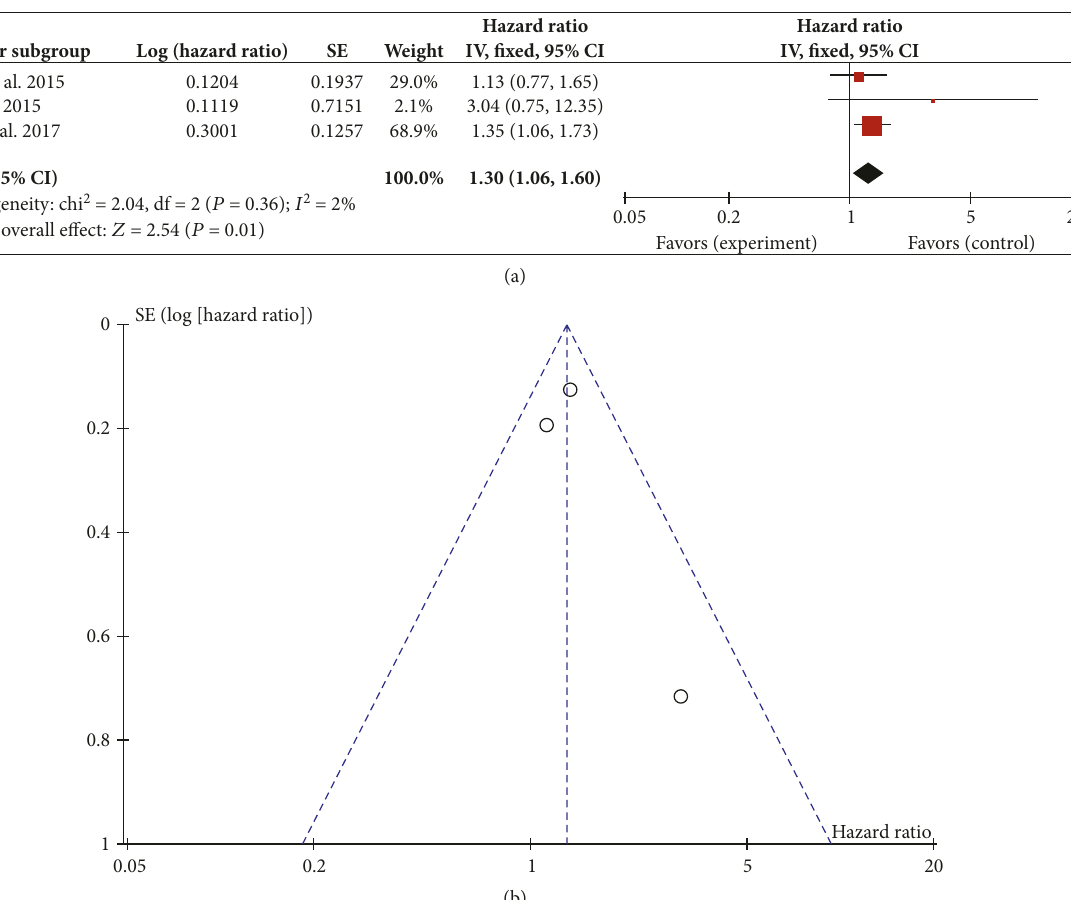
Figure 3: Correlation between platelet-to-lymphocyte ratio and disease-free survival. (a) Forest plot of comparison of the included trials; (b) funnel plot of comparison of the included